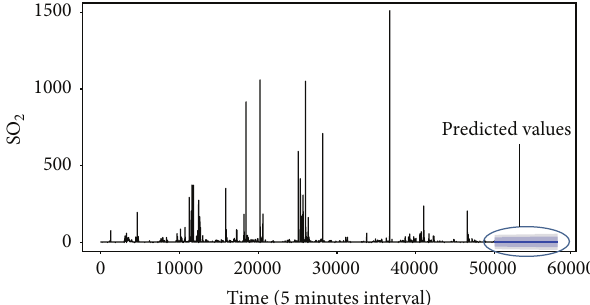
Figure 5: ARIMA (5,0,3): December 2012. Predicted SO 2 concen-